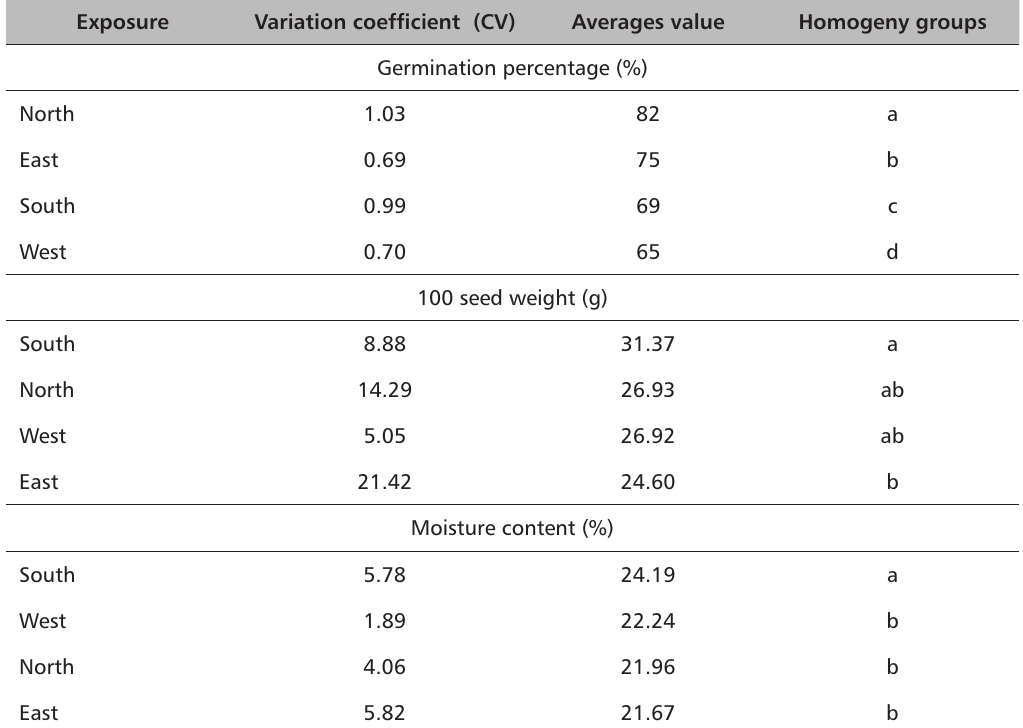
TABLE 4. Average value, variation coefficient (CV) and homogeny groups of exposure factor on seed characteristics of Oriental